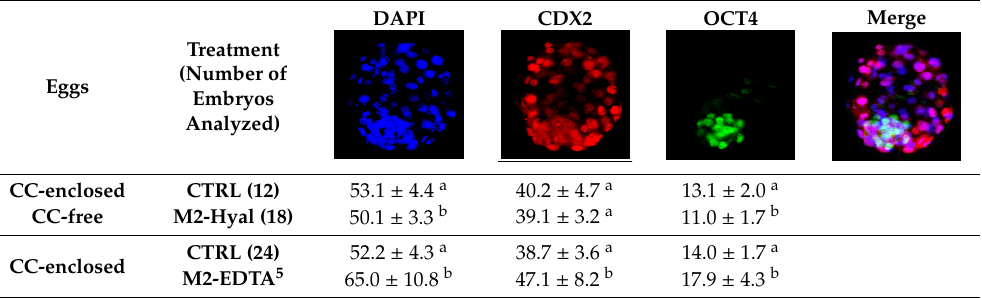
Table 2. Mean number ± s.d. of blastomeres counted in blastocysts at 96 h p.i. (DAPI) and of cells